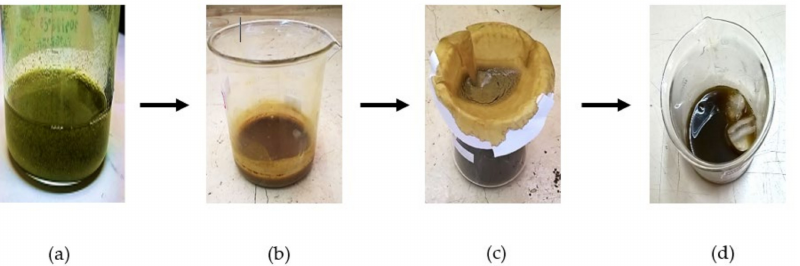
Figure 10. ( a ) Ethanol extract obtained via Soxhlet; ( b ) black pepper extract from the purification process; ( c ) filtration of tannins and precipitated phenolic compounds, and ( d ) supernatant, with the addition of solid distilled water for the precipitation of piperine crystals.